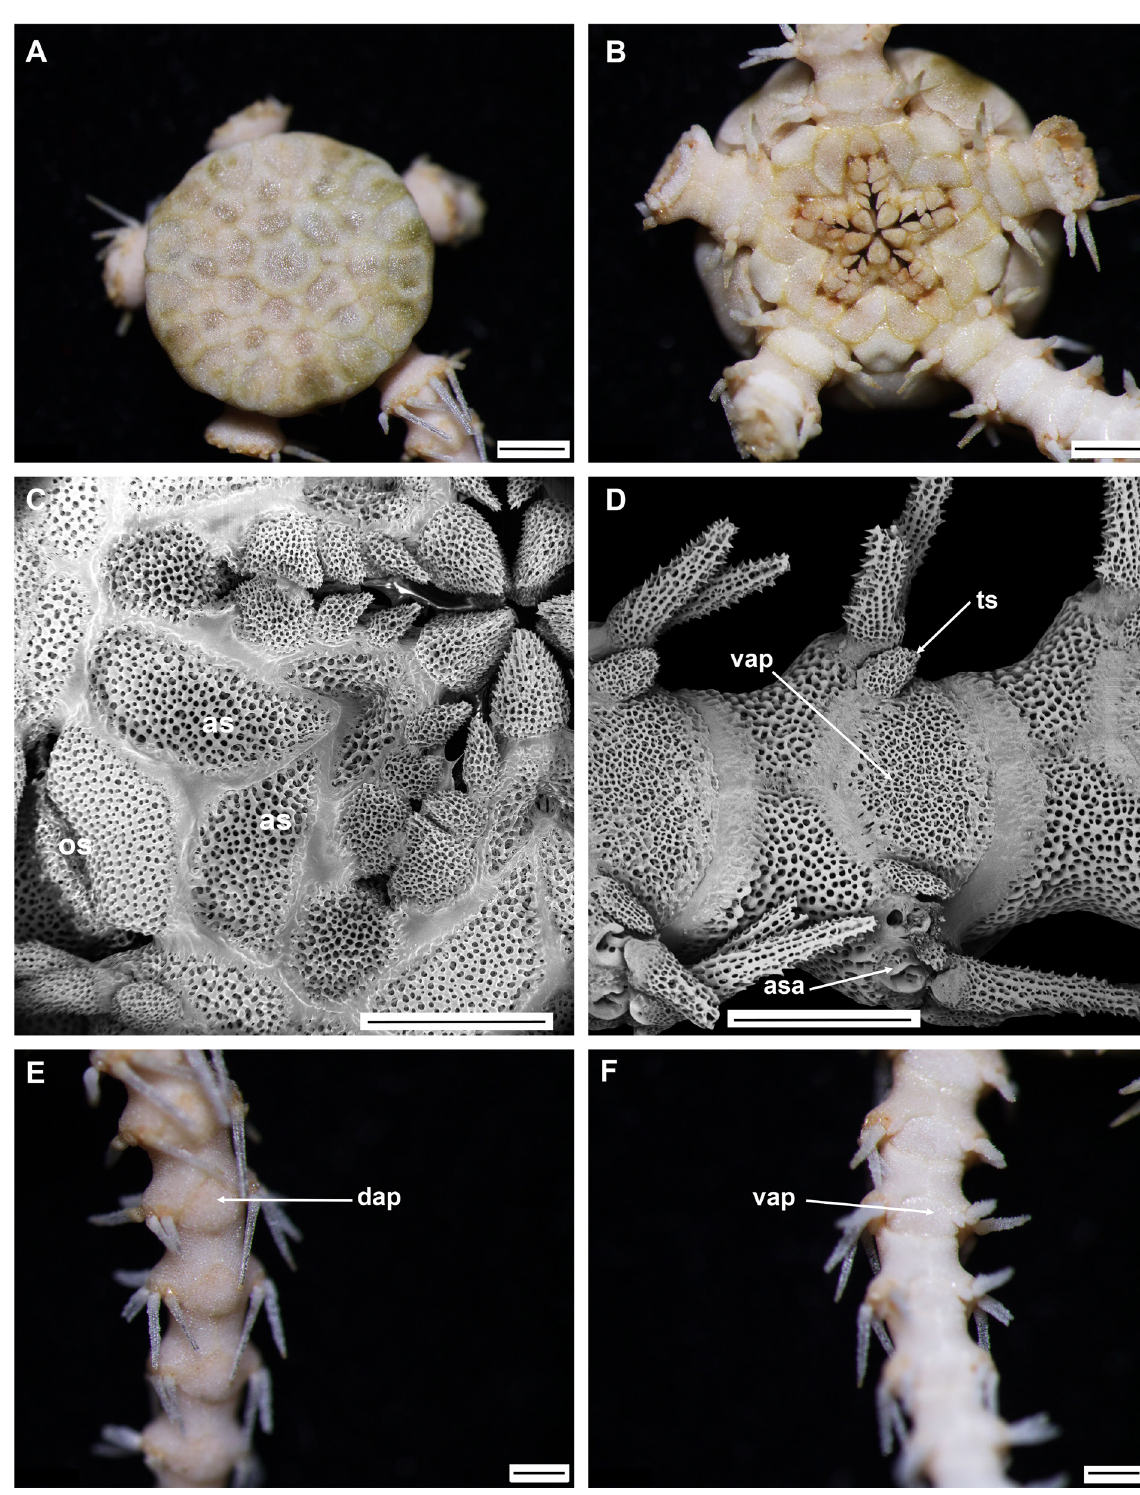
Fig. 23. Ophiurothamnus clausa (Lyman, 1878) (IDSSE EEB-SW0023). A . Dorsal disc. B . Ventral disc. C . Oral frame (SEM). D . Ventral arm (SEM). E . Dorsal arm. F . Ventral arm. Abbreviations: as = adoral shield; asa = arm spine articulation; dap = dorsal arm plate; os = oral shield; ts = tentacle scale; vap = ventral arm plate. Scale bars: A–B = 1 mm; C–F = 500